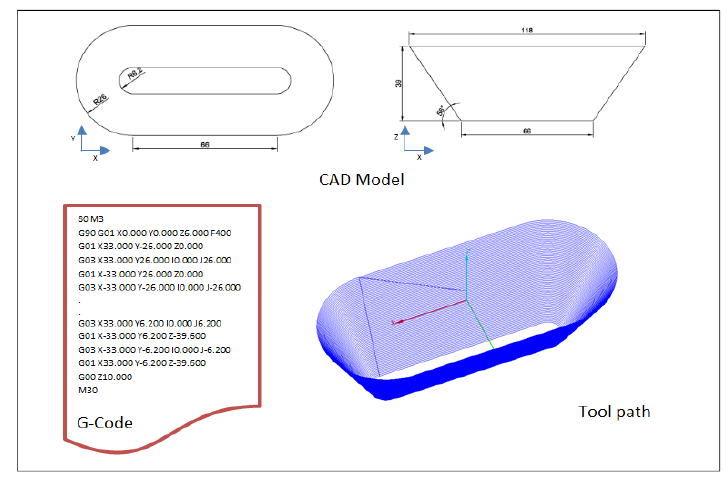
Fig. 2. Geometry of part and part program.